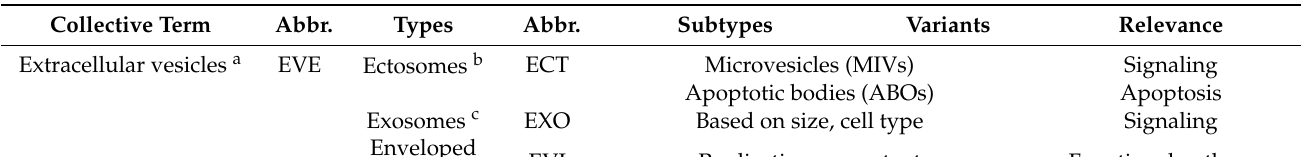
Table 1. a: Abbreviations and definitions of extracellular vesicles. b: Exosomal and viral components: definitions and abbreviations.